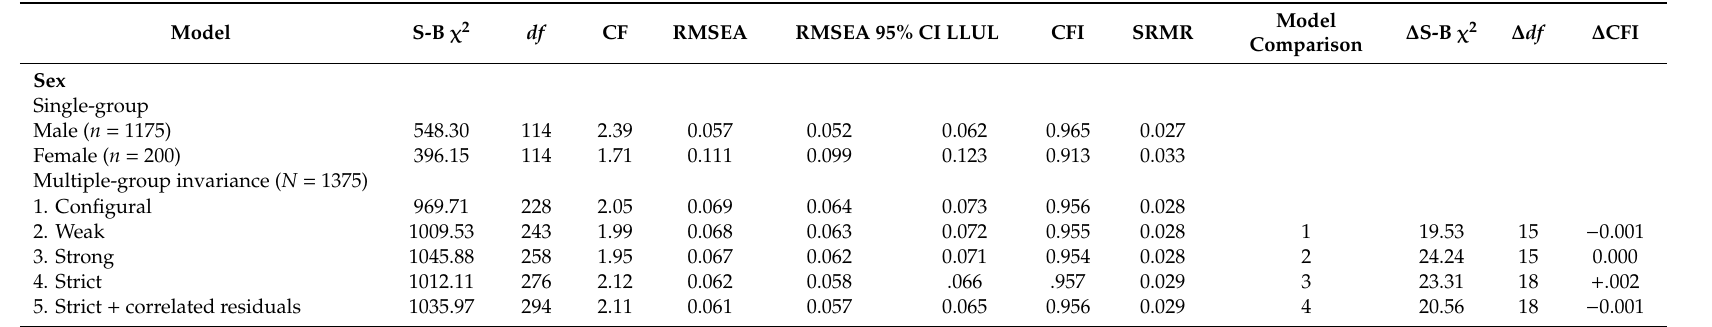
Table 2. Measurement Invariance